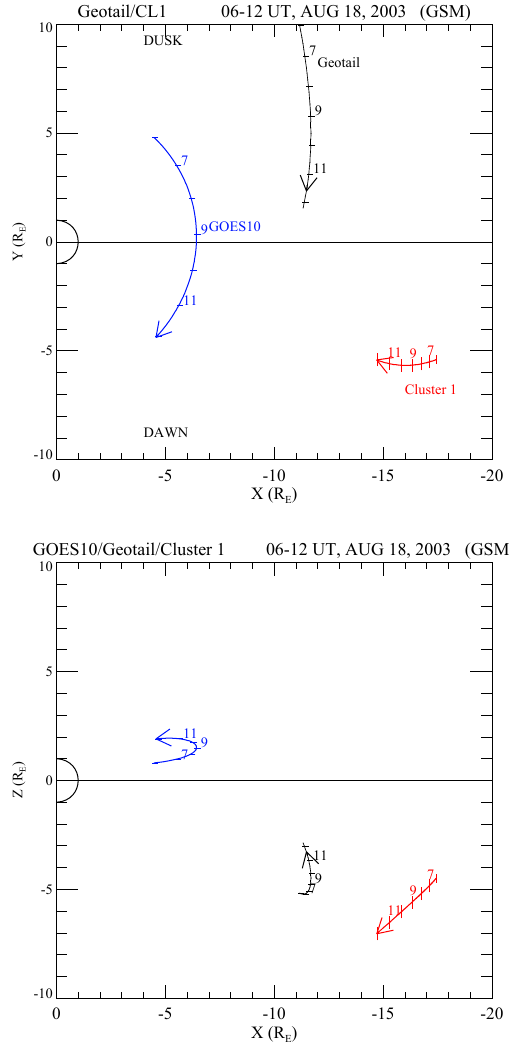
Figure 3. Tracks of three magnetospheric spacecraft in the GSM X – Y (a) and X – Z (b) planes during the interval 06:00–12:00UT. GOES-10 moved from dusk to dawn at geosynchronous altitude. Geotail moved in the azimuthal direction on the dusk side to- wards the midnight sector ( Y Geotail = 10 to 2 R E ; X Geotail = − 11 to − 12 R E ). Cluster 1 advanced earthward ( X Cluster - 1 = − 18 to − 15 R E ) on the dawn side ( Y = − 5 to − 6 R E ). GOES-10 was Cluster located in the Northern Hemisphere ( Z GOES - 10 = 1–2 R E ). Geo- tail and Cluster-1, respectively, were located in the Southern Hemi- sphere lobe/plasma sheet and the plasma sheet/lobe ( Z Geotail = − 5 to − 3 R E ; Z Cluster - 1 = − 4 to − 7 R E